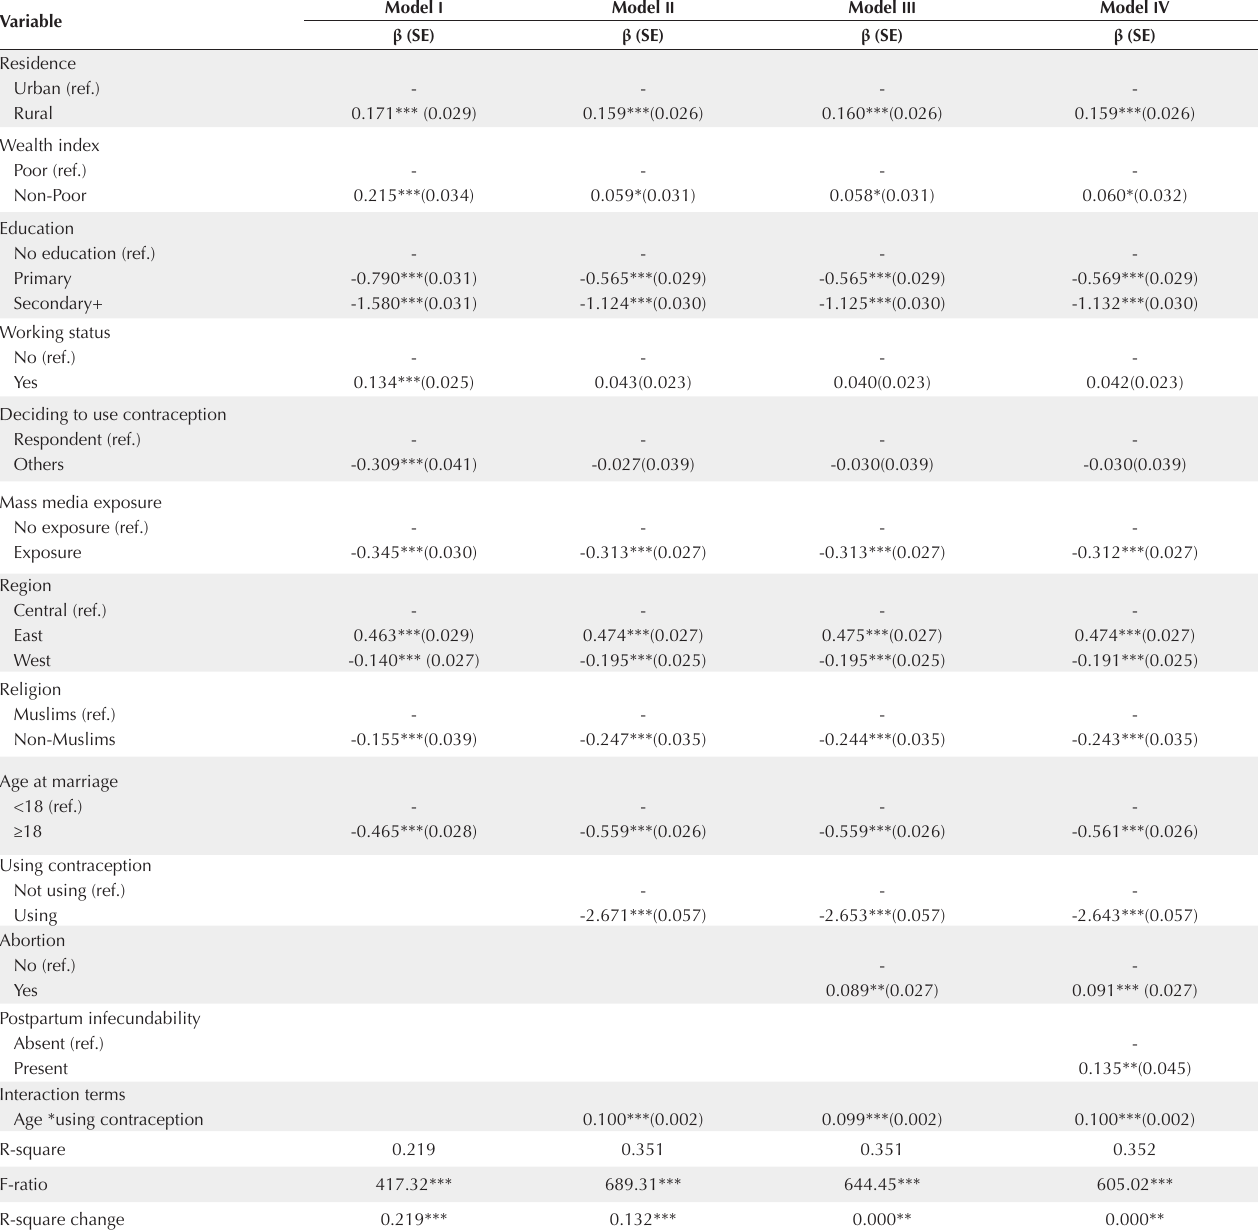
Table 2. Effect of Selected Socioeconomic Variables and Proximate Factors on Fertility Fluctuation (Multiple Regression Analysis Based on a Hierarchical Method)